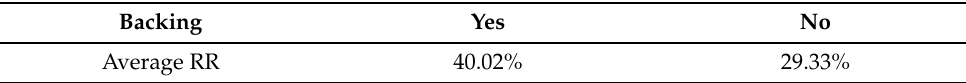
Table 8. Average recovery rate for bonds with and without